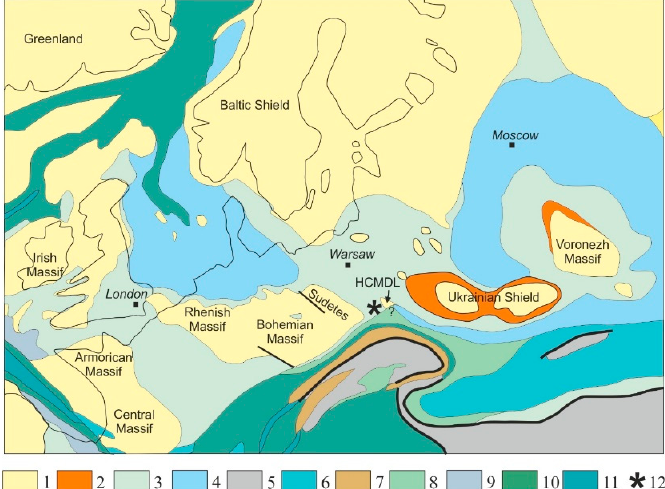
Figure 2. Albian palaeogeography of epicontinental sea and adjacent western Tethys of Europe with simplified distribution of facies (modified from, [1,12]); 1—Land areas; 2—Deltaic, coastal, and shallow marine clastic facies (sands and conglomerates, sands and shales); 3—Shallow-marine facies (sands, marls, carbonate marls, marly carbonates, carbonates); 4—Mainly shallow-carbonate marine facies (marly carbonates, carbonates, chalk, white chalk, carbonate shales); 5—Active fold belts, high relief; 6—Marine carbonates; 7—Deeper marine clastics (sand and shales); 8—Deeper marine carbonates (sands and shales); 9—Carbonates and sands; 10—Deeper marine facies (sands and shales, shales); 11—Deeper marine shale facies (the area of rift); 12—Miech ó w area; HCMDL—hypothetic Holy Cross Mountains–Dobruja Land; ?—no precise data for the southern edge of the